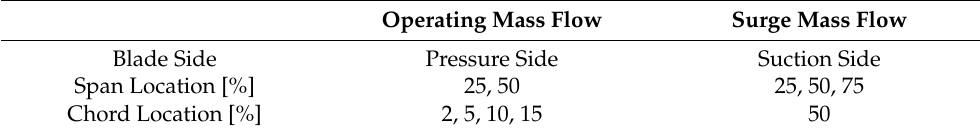
Table 2. Suction actuator